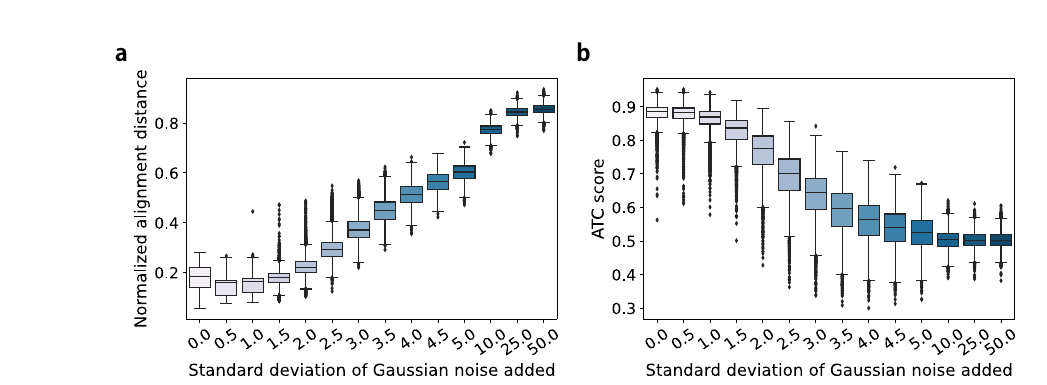
Fig. 2 | Assessment of CAPITAL ’ s feasibility in clustering quality on the syn- thetic datasets. a A test in global topological similarity on 53,987 pairs of trajec- tories. Reference shows the results of trajectory alignments with no nodes in one trajectory tree removed. The other cases where a node was removed in one tra- jectory tree are classi fi ed into seven types. A number shown in parentheses on the horizontalaxisshowsthenumberofchildrenofthenodetoberemoved.10nearest